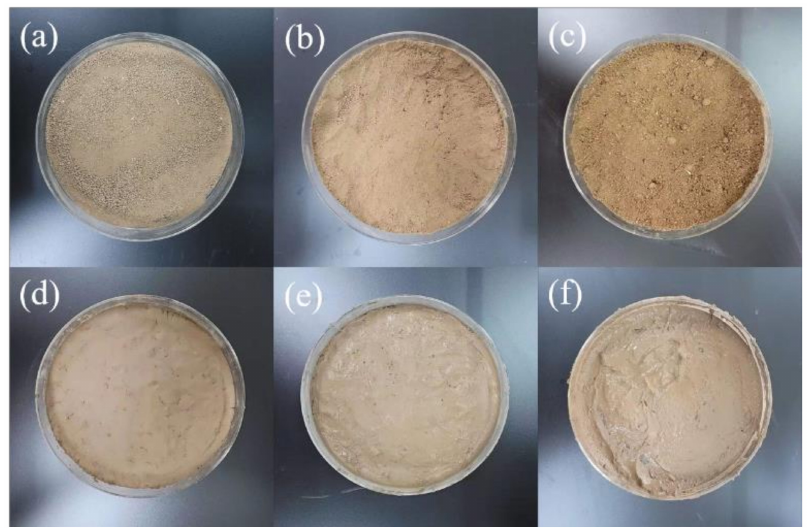
Figure 1. Images of soils with different SMCs (0% ( a ), 8% ( b ), 16% ( c ), 24% ( d ), 32% ( e ) and 40% ( f